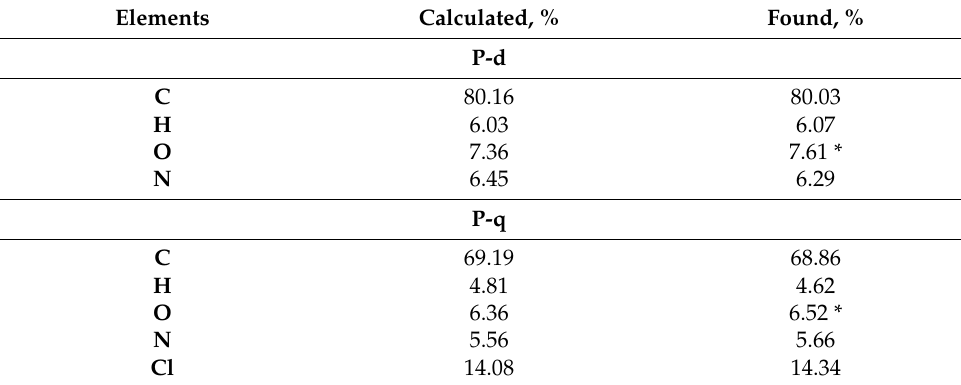
Table 3. Elemental analysis data for benzoxazine monomers.